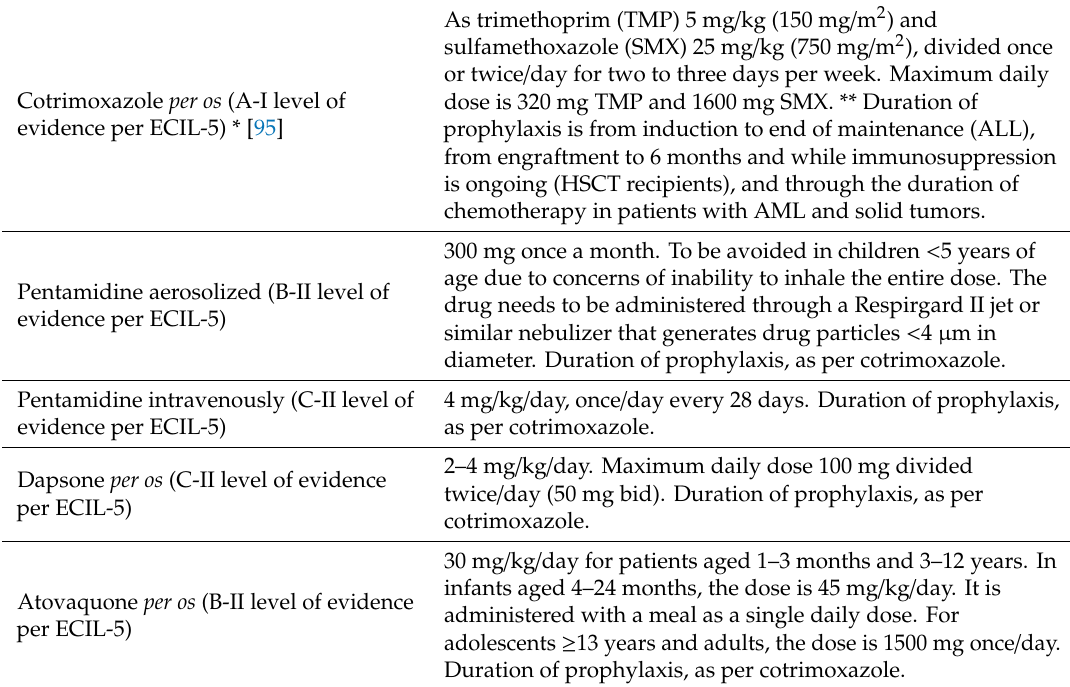
Table 3. Prophylactic regimens for PJP in children with leukemia and HSCT